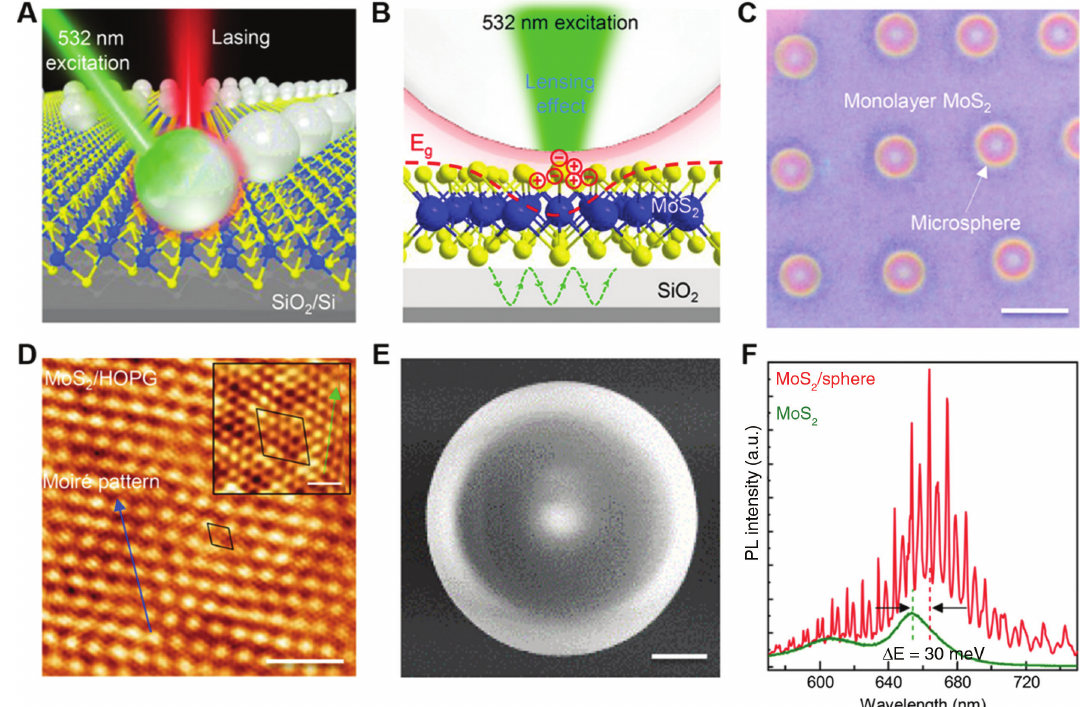
with microsphere. Figure 5: Optically pumped lasing from monolayer MoS 2 (A) Schematic diagram for microsphere cavity on top of monolayer MoS , with red lasing under 532 nm excitation. (B) Lasing principle 2 shows the localized carriers and the strong coupling between gain medium and cavity modes. (C) Optical micrograph of microsphere arrays on monolayer MoS . Scale bar, 15 μ m. (D) Moire﻿́-scale STM image of monolayer MoS transferred on pyrolytic graphite (HOPG) substrate; 2 2 scale bar, 4 nm. Inset gives the magnified view; scale bar, 0.8 nm. The arrows lie along moire﻿́ pattern (blue) and the S atoms (green) for MoS monolayer, respectively. Rhombus shows the unit cell for moire﻿́ pattern giving a period of about 1.06 ± 0.05 nm. (E) SEM image for a 2 representative microsphere showing the clean and smooth surface; scale bar, 2 μ m. (F) Lasing spectrum of MoS /sphere and PL spectrum of 2 monolayer MoS on SiO /Si substrate, under 532 nm laser excitation at power density of ~ 980 W/cm 2 . Reprinted with permission of Ref. 2 2